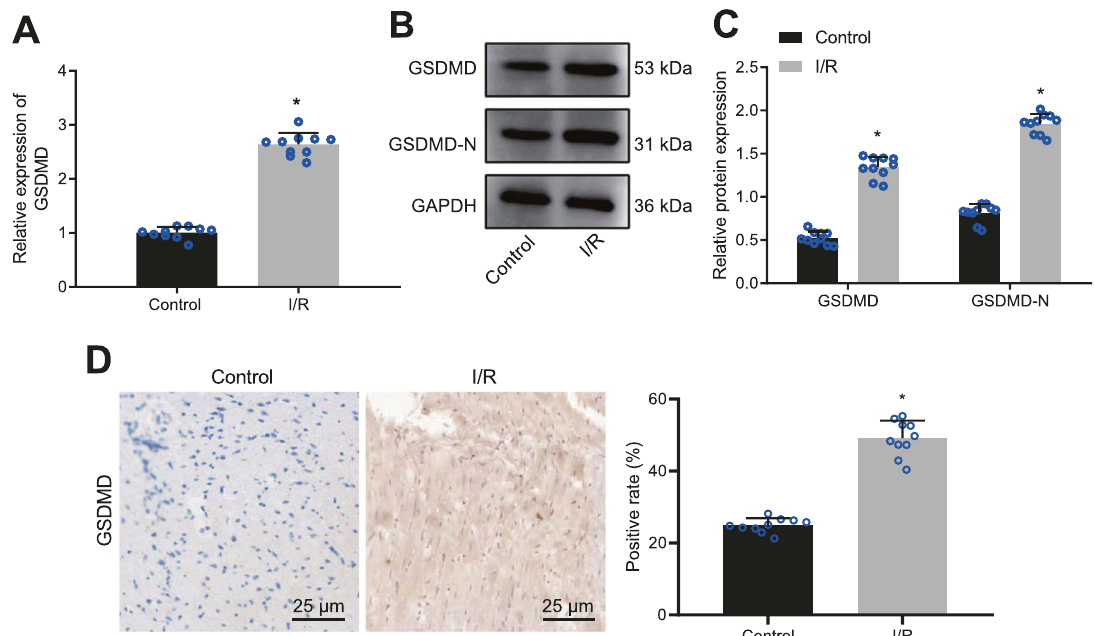
Fig. 2 GSDMD is robustly expressed in myocardial tissues of I/R mice. A mRNA expression of GSDMD in myocardial tissues of mice with I/R detected by RT-qPCR, normalized to GAPDH; B Representative images of GSDMD and GSDMD N protein bands in myocardial tissues of mice with I/R. C Western blot analysis of GSDMD protein and GSDMD N in myocardial tissues of mice with I/R, normalized to GAPDH; D Immunohistochemistry staining of GSDMD protein in myocardial tissues of mice with I/R. N = 10 for mice in each group. Measurement data were expressed as mean ± standard deviation. Data comparison between two groups was conducted by unpaired t -test. * p < 0.05 vs. sham- operated